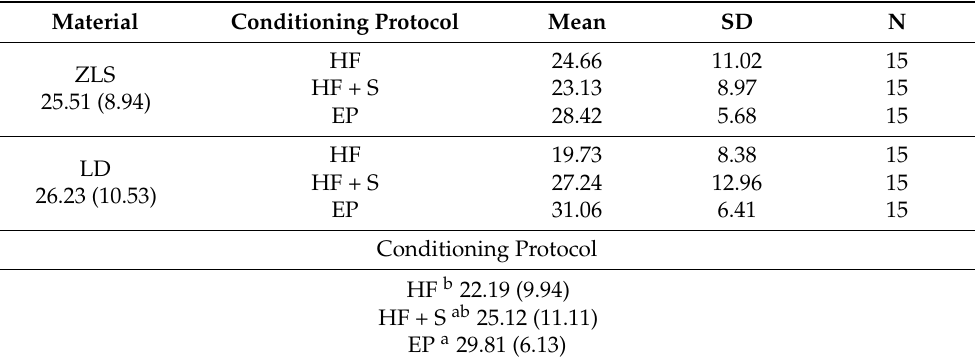
Table 1. Mean µ SBS (MPa) and standard deviations (SD) of RelyX Unicem 2 to VITA Suprinity (ZLS) and IPS e.max CAD (LD) after conditioning with hydrofluoric acid (HF), hydrofluoric acid plus silane (HF + S), and Monobond Etch & Prime (EP). Different letters label statistically significant differences in bond strength.